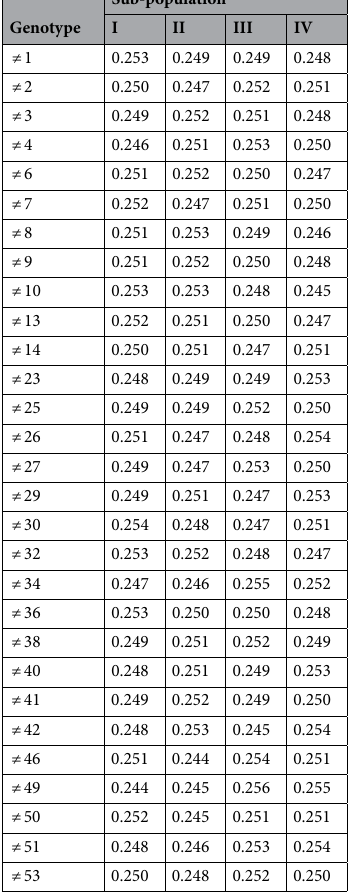
Table 7. Membership coefficient of squash genotypes in four subpopulations.